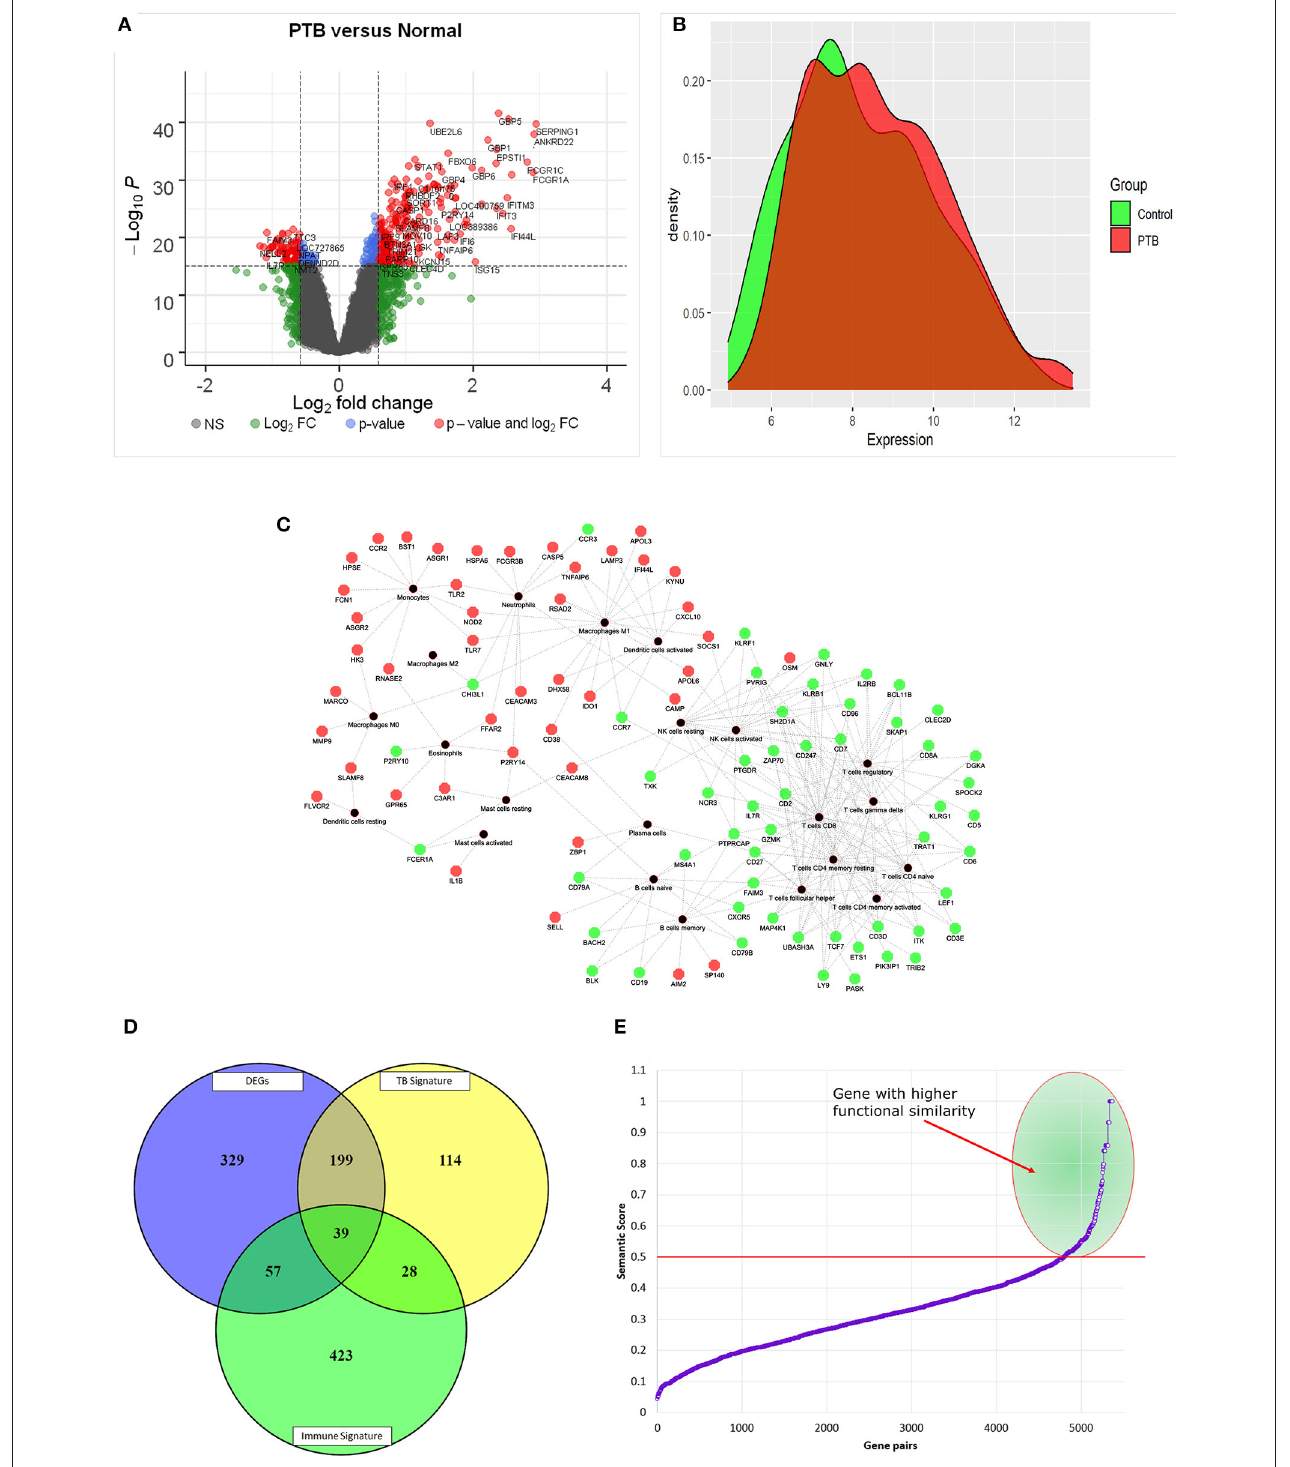
FIGURE 3 | Graphical distribution of differentially expressed genes. (A) Volcano plot representing the distribution of fold change and p-value significance. (B) The distribution mean intensity of differentially expressed genes in the PTB and control samples. (C) Red and green nodes represent up and downregulation of genes and black nodes are the immune cell types. (D) The Venn diagram represents the overlap of DEGs with immune and TB signatures. (E) Semantic similarity of pairs of genes between differentially expressed immune signatures and TB signatures. The selected gene pairs with higher functional similarity ( ≥ 0.5) are highlighted in green color.